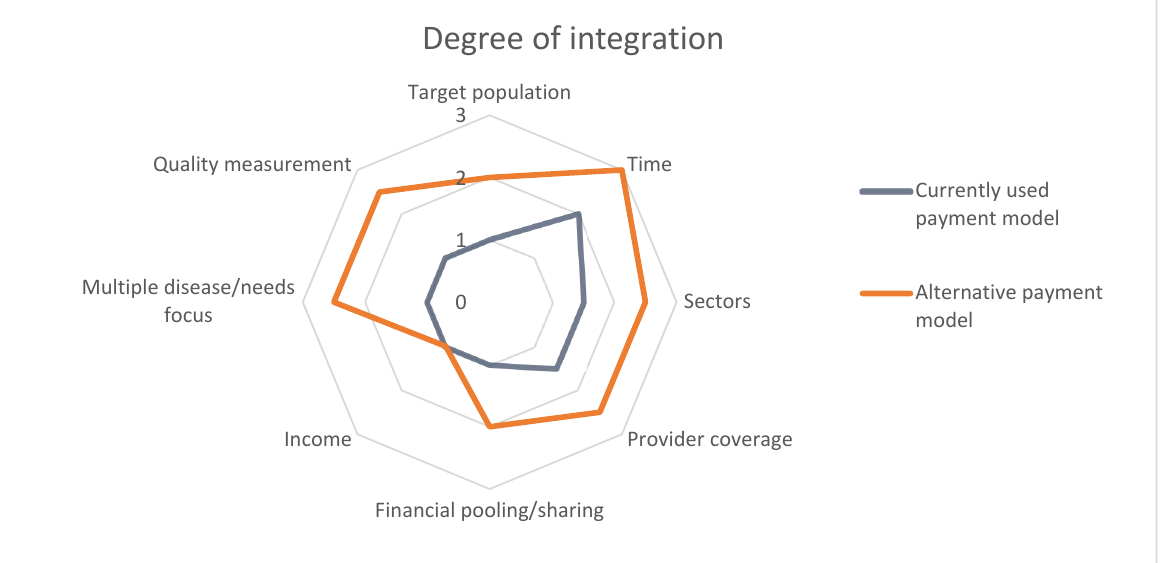
Figure 4. Degree of integration. Table 4. Description of the level of integration expected to result from the proposed payment model.